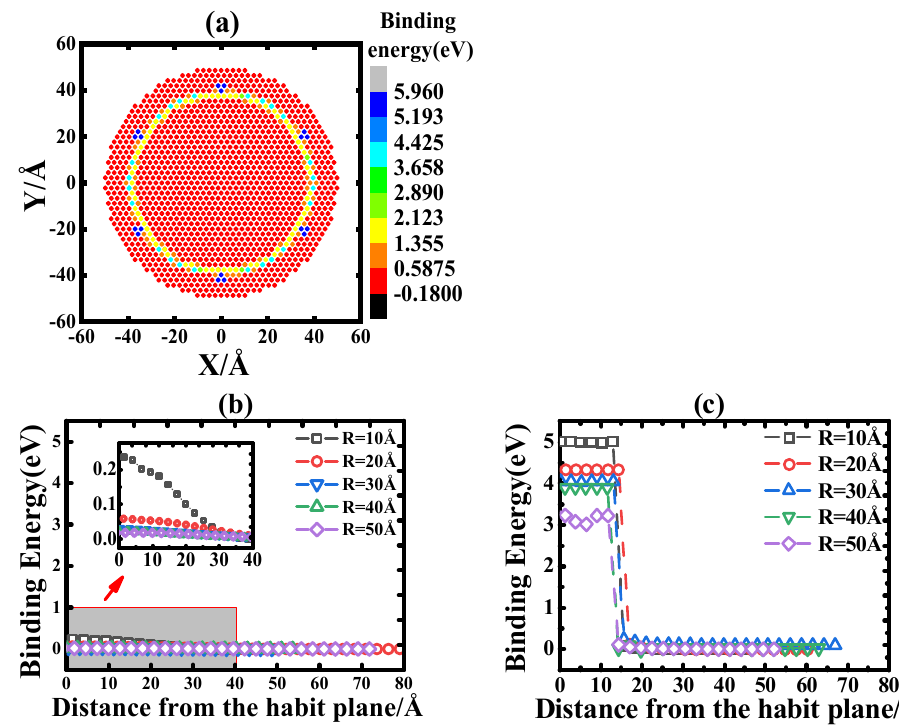
Figure 2. The distribution of binding energies of an IDL to a vacancy when the vacancy is placed on the HP ( a ), along the Direction I ( b ), and along the Direction II ( c ), respectively. The inset figure shows the binding energies at a small energy scale.